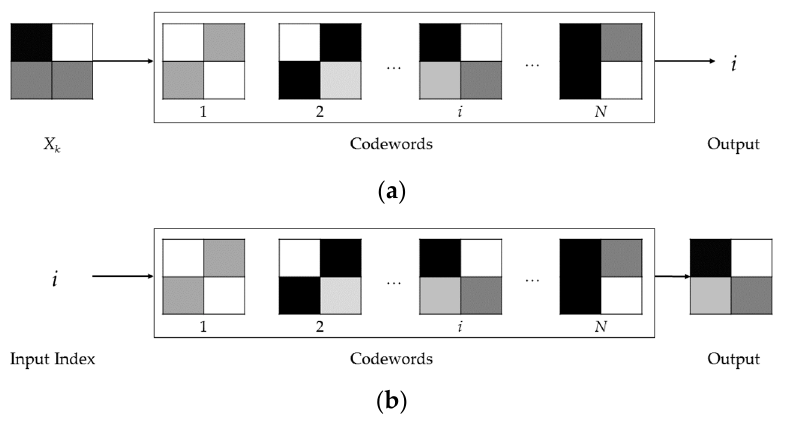
Figure 1. The usage of the VQ by an encoder ( a ) and by a decoder ( b ).